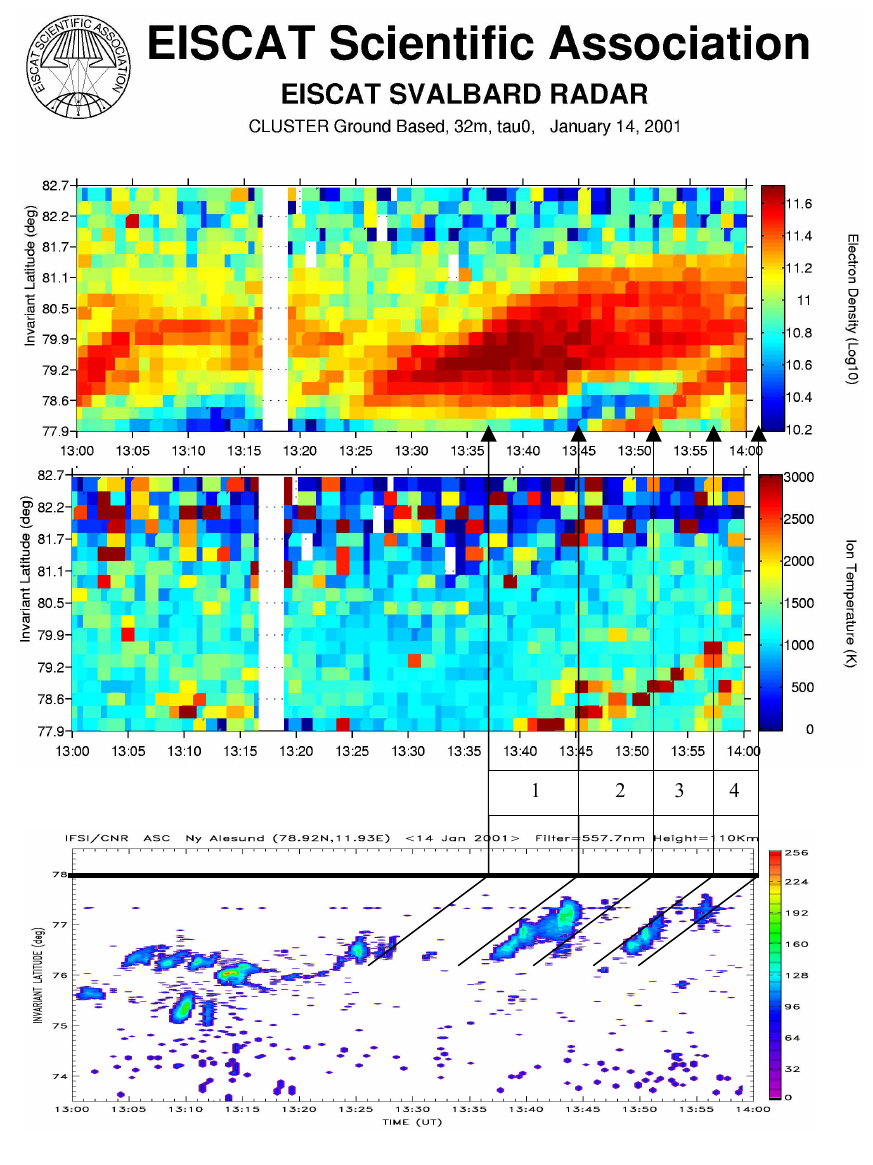
Fig. 13. Comparison of EISCAT ESR data versus latitude and time of elec- tron density (top panel) and ion tem- perature (central panel) with a keogram from optical observations of 557.7nm emissions by the Itaca all-sky camera, located just to the south of the range of the ESR poleward pointing beam. The heavy black line in the keogram marks the lowest latitude in the ESR data, and the thin arrows are guidelines to con- nect the regions void or filled with au- rora to corresponding regions of low and high electron density (respectively, high and low ion temperature) in the ESR